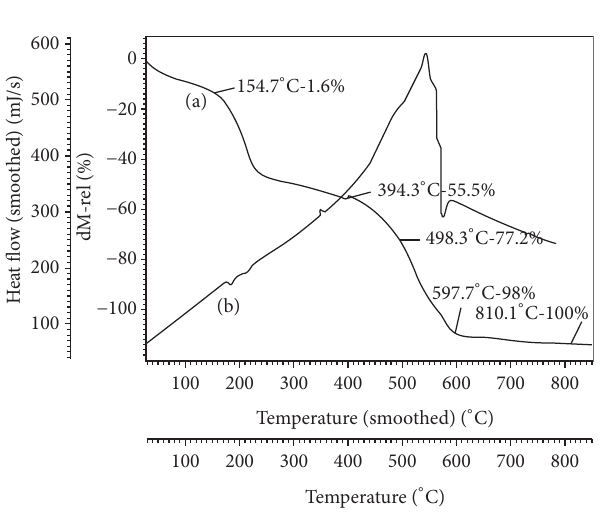
F 6: TG curve (a) and DTA curve (b) of o-NH